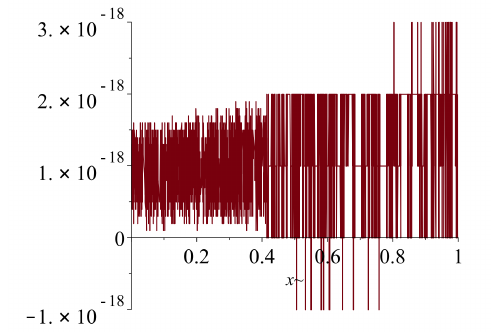
Fig. 2. Absolute errors of the approximate solution of problem (31) for Λ = 2.